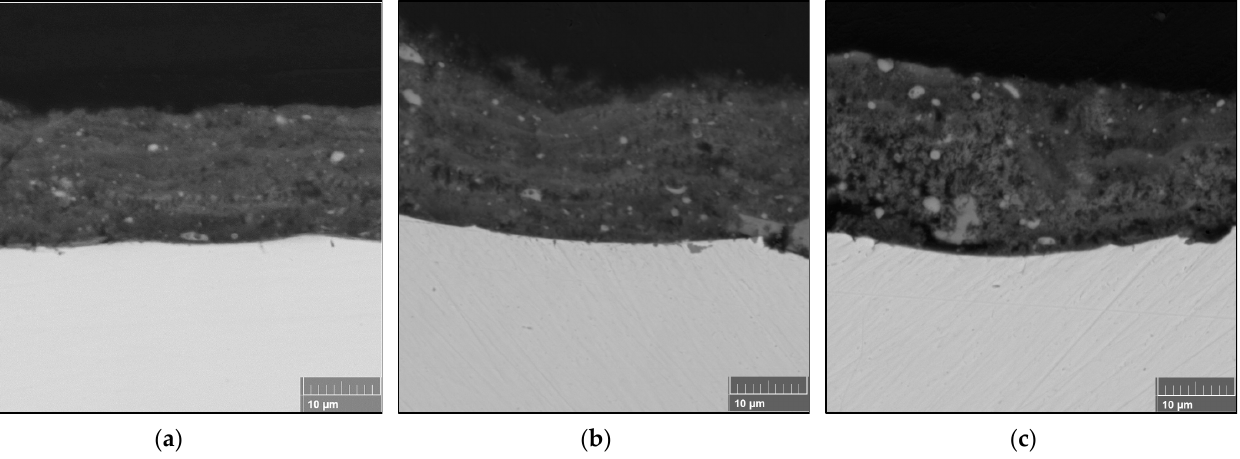
Figure 6. Cross-section of the coatings obtained from full-pass sprayed (0.6 M) TiO 2 solution when the number of passes was increased to 30 at ( a ) 40 mm, ( b ) 50 mm, and ( c ) 60 mm stand-off distances